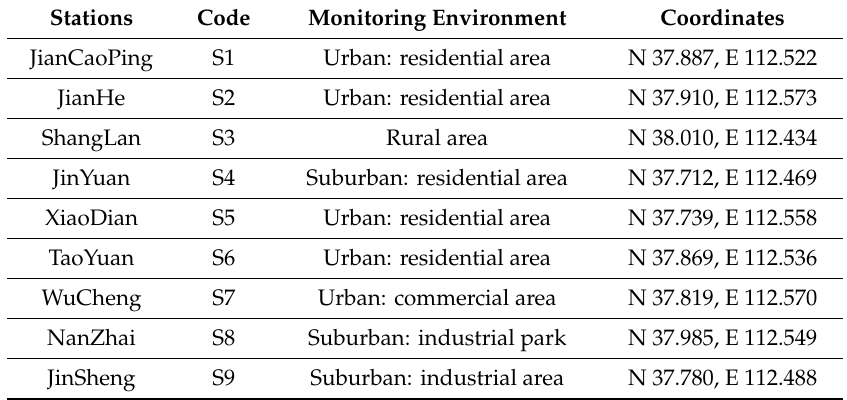
Figure 3. ( a ) The location map of Taiyuan City; ( b ) distribution of air quality monitoring stations in Taiyuan City. Table 1. Characteristics of Taiyuan air quality monitoring stations. N—north; E—east.